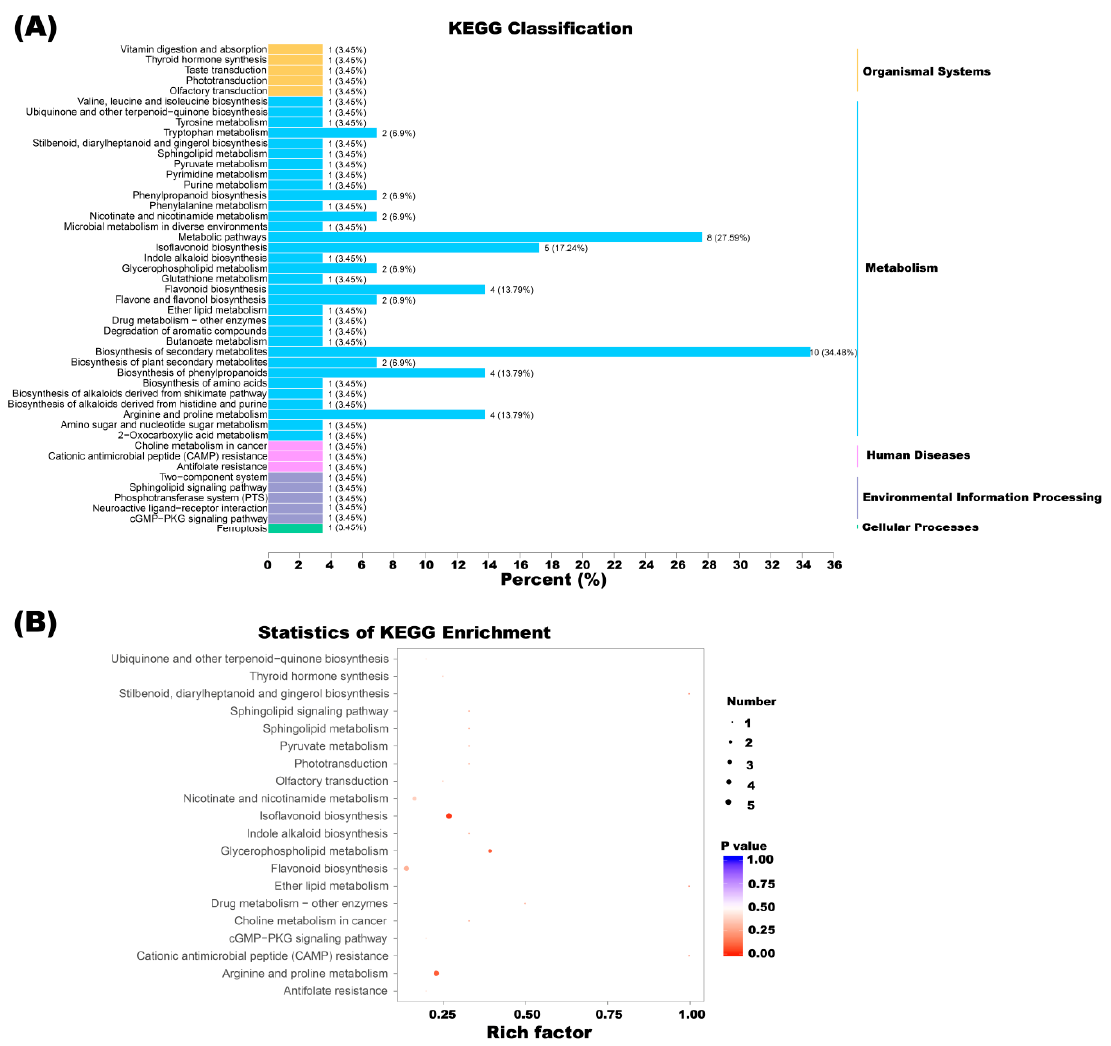
Figure 7. Cluster of different types and pathway analysis of differential metabolites for NJCMS5A and NJCMS5B. ( A ) KEGG classification of 47 pathways from 29 differential metabolites. The x axis indicates the proportion and number of metabolites annotated to the pathway, and the y axis indicates name of the KEGG metabolic pathway; ( B ) Statistics of KEGG enrichment. The x axis indicates the rich factor corresponding to each pathway, and the y axis indicates name of the KEGG metabolic pathway. The color of the point represents the p -values of the enrichment analysis. The size and color of bubbles represent the number and degree of enrichment of different metabolites, respectively.